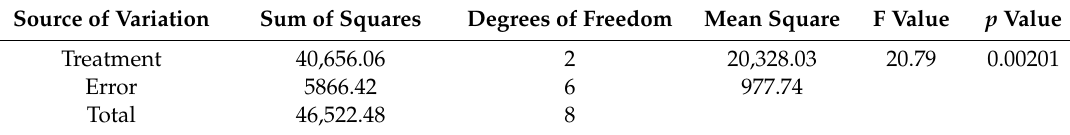
Table 2. One-way ANOVA for untreated and treated soil specimens based on their UCS values. Source of Variation